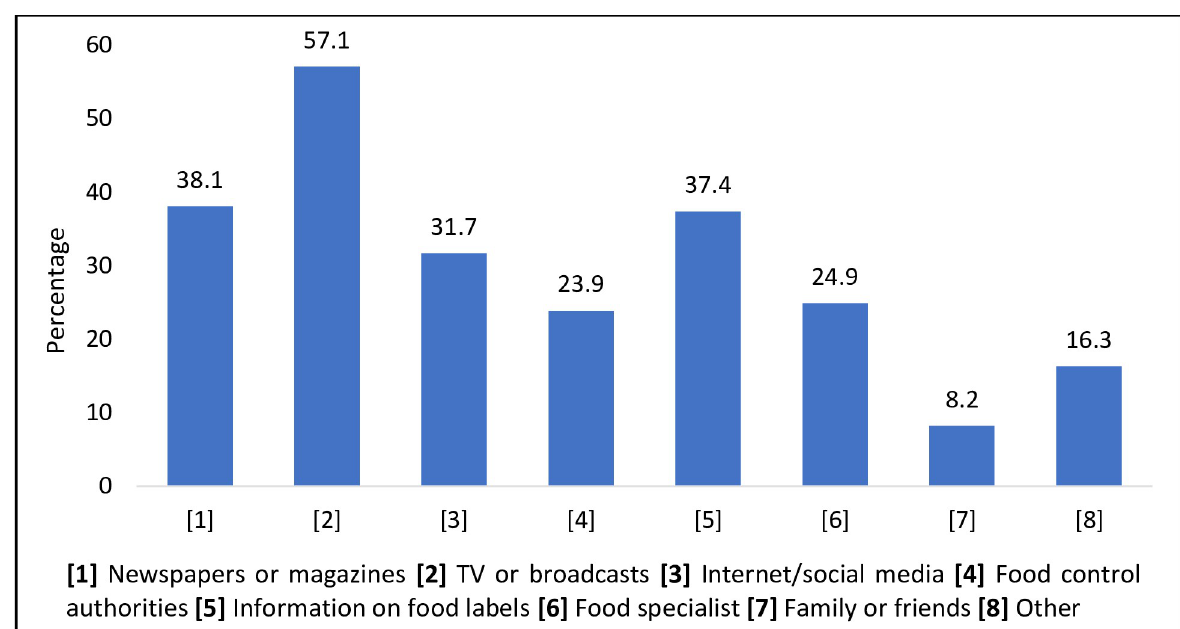
Fig 1. The different sources of respondent knowledge about food additives (n =